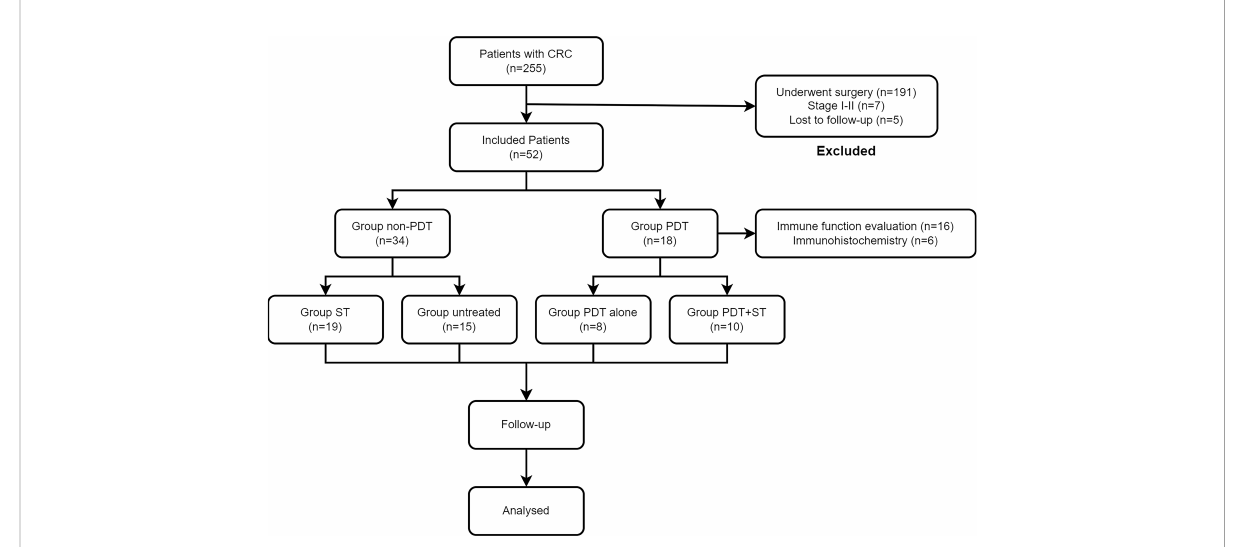
FIGURE 1 Flowchart of all patients in this study. CRC, colorectal cancer; PDT, photodynamic therapy; ST, systemic